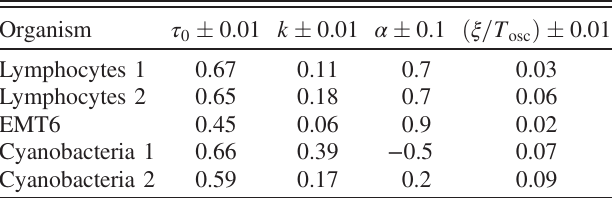
TABLE II. Parameters ’ values [defined in Eq. (1)] extracted from the fitting procedure for the experiments with large Δ . τ 0 ¼ 24 h in all sets and k are in units of T (we assumed T osc osc ¼ 23 . 16 h). except Cyanobacteria 1; the measured value was T osc ξ values are taken from Table I.